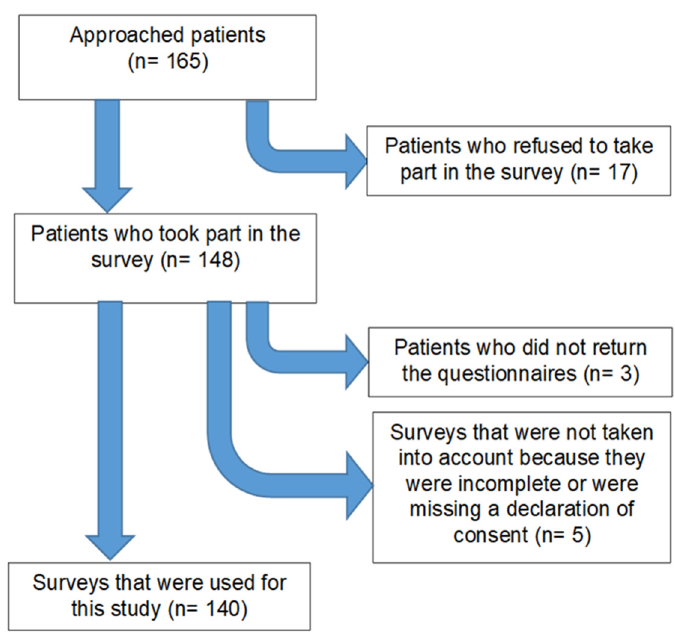
Figure 2. Flowchart describing the process of patient acquisition for this survey.